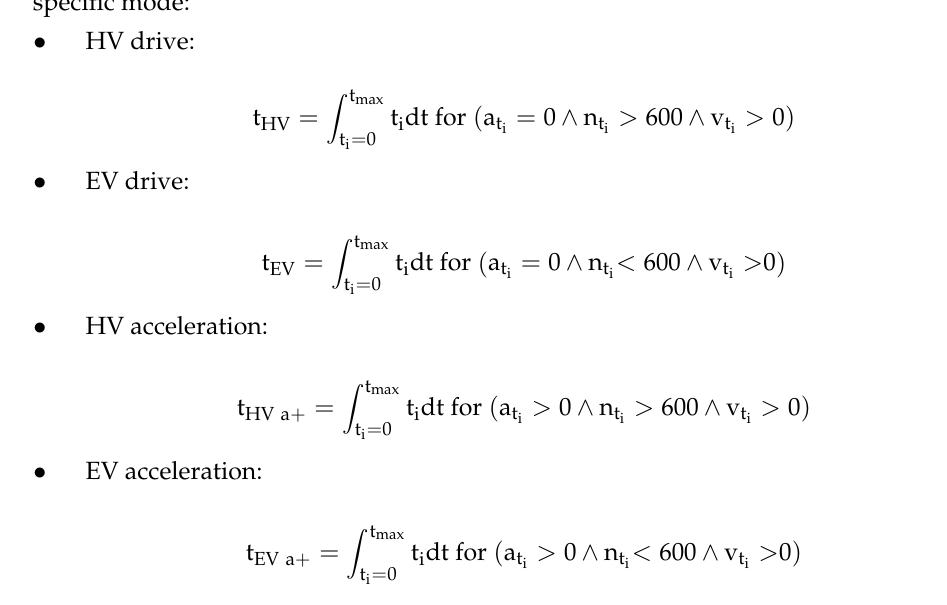
charging energy and energy recovered during vehicle braking; ( d – f ) between energy recovered